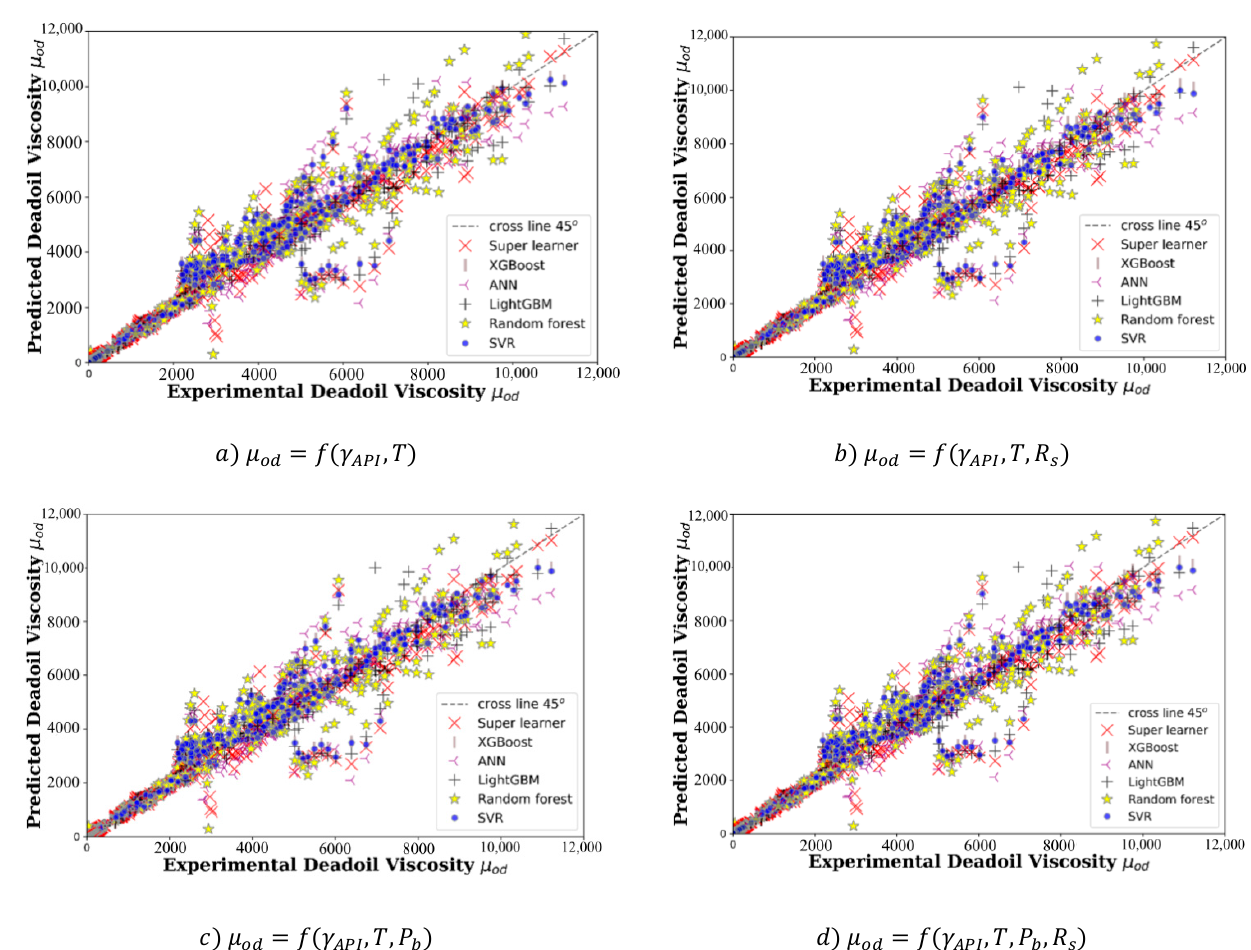
Figure 2. Experimental data vs. predictions on testing datasets for four different forms of µ od .